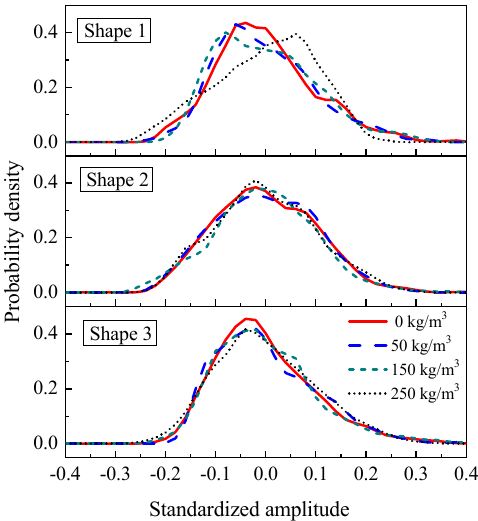
Figure 11. Profile of probability density of the maximum fluctuating pressure for three shapes at various sediment concentrations in 2.20 m upstream water levels. various sediment concentrations in 2.20 m upstream water